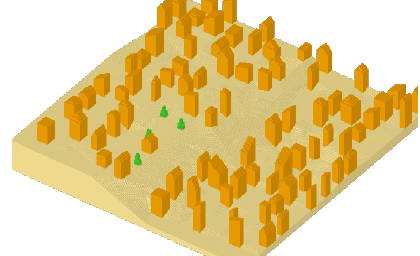
Figure 9. The 3D terrain topography and features